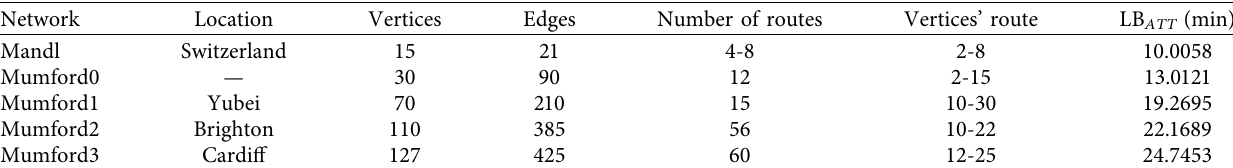
Step 4 . Use the roulette wheel selection method to choose a route from Z based on the values of proba- bilities p z . As soon as a route z is selected, route m and route z are combined into a new route according to Figure 4. The new route serves the travel demands and